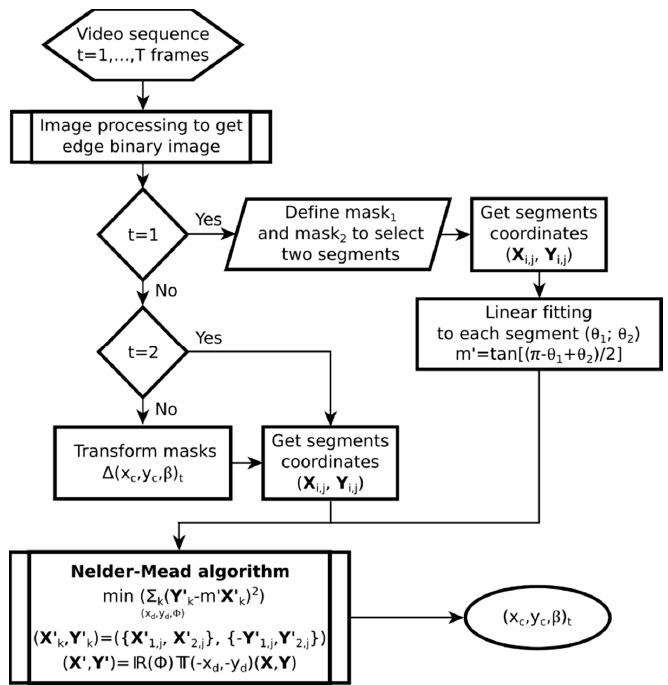
Figure 3. Flow chart for the algorithm.